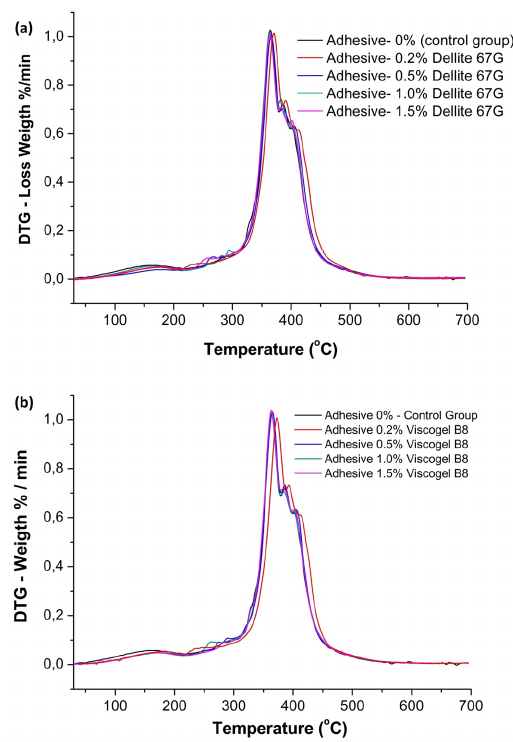
Figure 3. DTG of adhesives containing varying concentrations of the clays Dellite 67G (a) and Viscogel B8 (b)